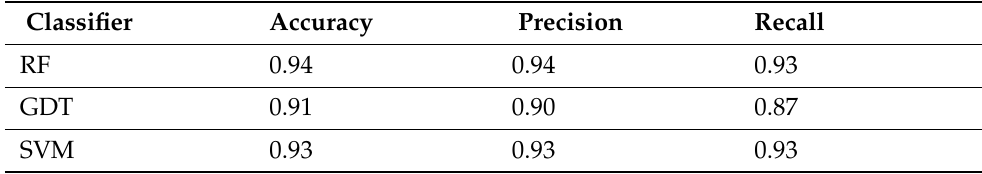
Table 2. Accuracy, precision, and recall for all of the classifiers tested.